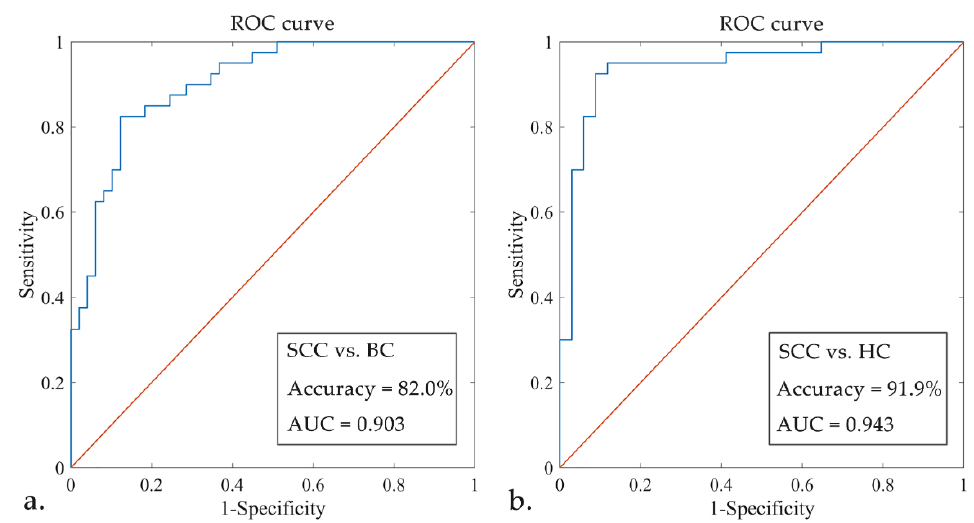
Figure 4. The ROC curves of SVM models. Part ( a ) showed ROC curves of SVM models for discriminating the SCC from BC group, and part ( b ) showed ROC curves of SVM models for discriminating the SCC from HC group. Abbreviations: ROC, receiver operating characteristic; AUC, area under the curve.